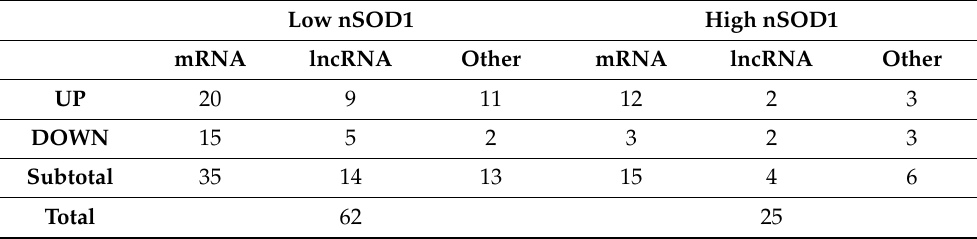
Table 2. Differentially expressed genes reported according to deregulation and gene biotype. Low nSOD1 High